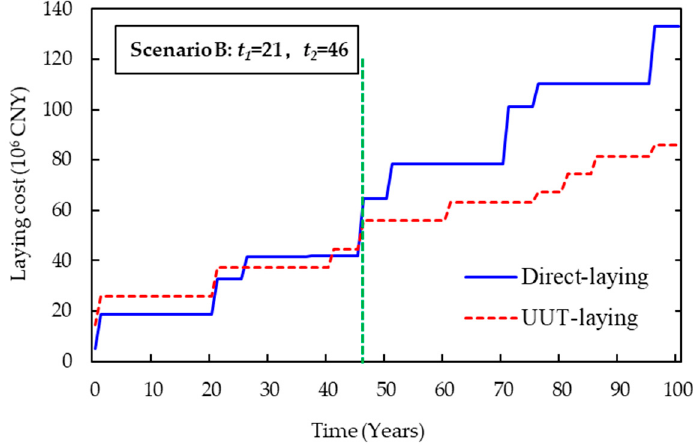
Figure 7. Comparison of power pipeline laying costs under Scenario B.